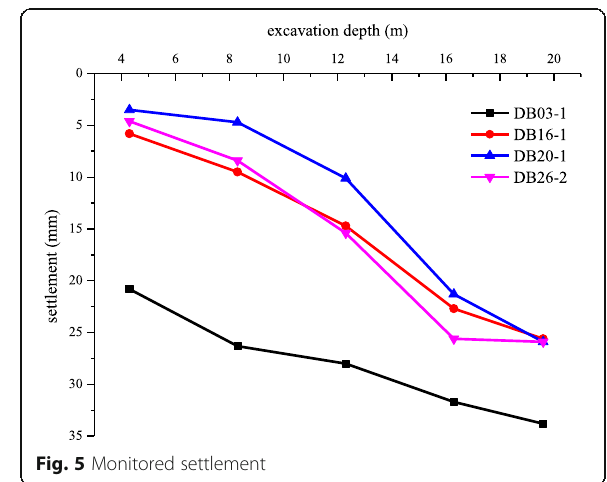
Fig. 5 Monitored settlement